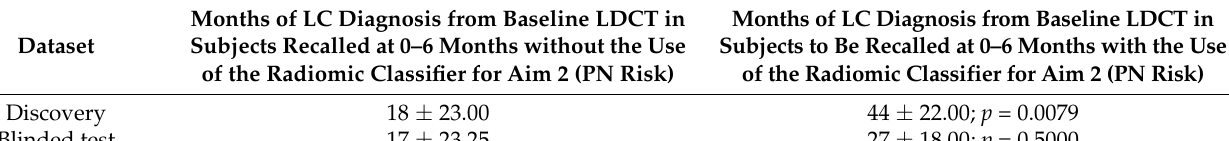
Table 5. Months of LC diagnosis from baseline LDCT scan in subjects recalled at 0–6 months. Month distributions for the LDCT recalls, as well as for the LC predictions, yielded by the proposed radiomic classifier, are expressed as median ± interquartile range values. Month distributions of the detection of LC with the proposed radiomic classifier are compared against the month distributions of the reference standard LDCT recalls after 0–6 months using the Wilcoxon rank sum test (with a significance level of 0.05). The p -values were adjusted using the Bonferroni–Holm method for multiple comparison